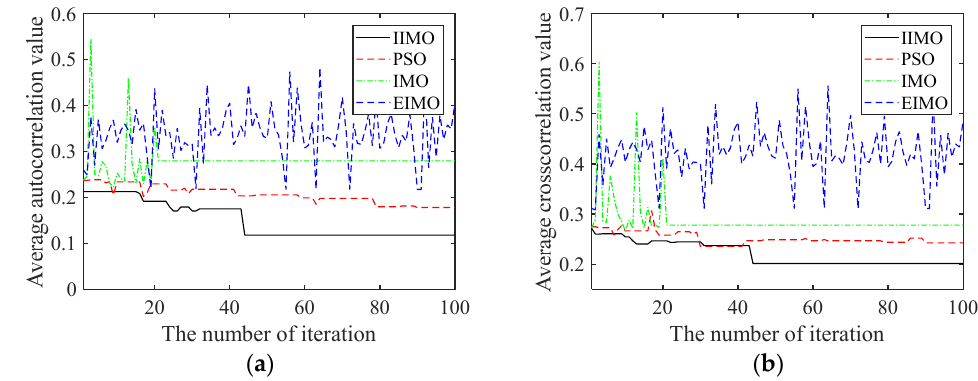
Figure 5. Average autocorrelation and cross-correlation values comparison of particle swarm opti- mization (PSO), IMO, enhanced ions motion optimization (EIMO), and IIMO under L = 4 and N = 40 on ( a ) Average autocorrelation, ( b ) Average cross-correlation.